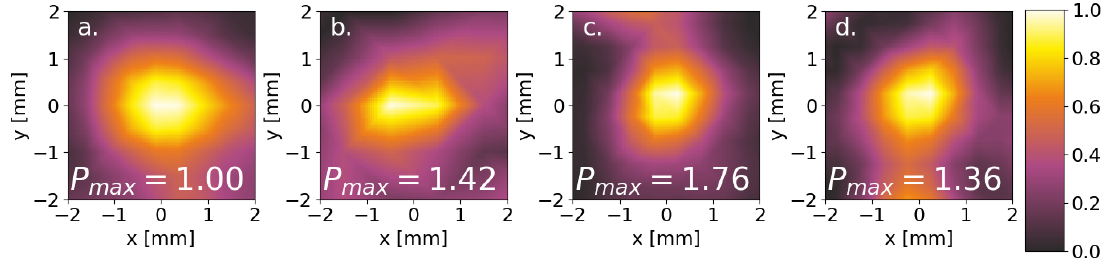
Figure 6. Off-axis focal spots, obtained from ( a ). PA12 lens, ( b ). transparent paraffin lens, ( c ). white paraffin lens and ( d ). reused paraffin lens. All images are normalized to unity, while the maximum power detected for each structure in respect to the PA12 lens is denoted as P max .